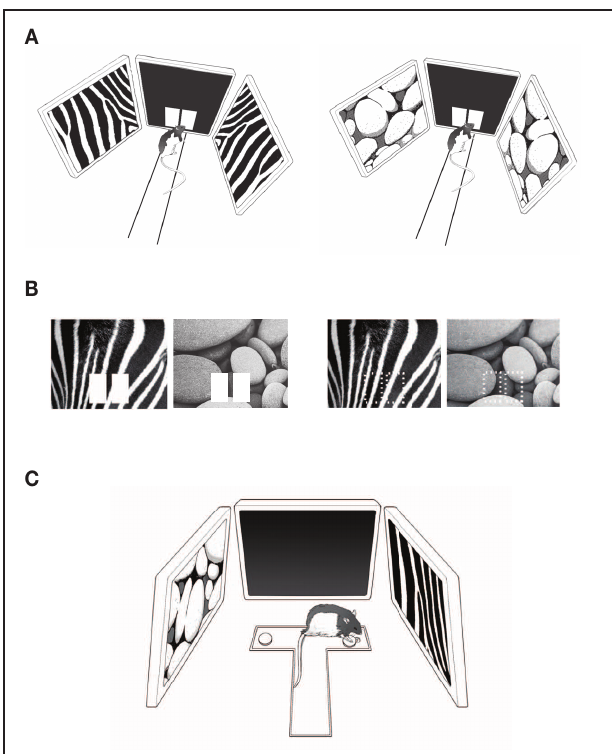
FIGURE 1 | Behavioral paradigms. (A) The pVCRS task. The rat was required to touch one of the response boxes (white rectangular images) presented in the center touchscreen monitor by using peripheral visual contexts (zebra and pebbles patterns) in the side monitors. The start box was omitted for illustration purposes. (B) The cVCRS task. The visual context was presented in the center touchscreen as a background of the response boxes ( left ) or by itself without the response boxes ( right ; the response areas are indicated by dotted rectangles for illustration purposes only). Only the center touchscreens were illustrated here without peripheral monitors and the apparatus for simplicity. (C) The VPD task. The two visual contexts were presented via the side monitors and the rat chose the correct arm (right arm associated with the zebra pattern in this example) of the T-track after entering the center stem. Displacing the metal washer revealed a food well and the rat retrieved a food reward from the food